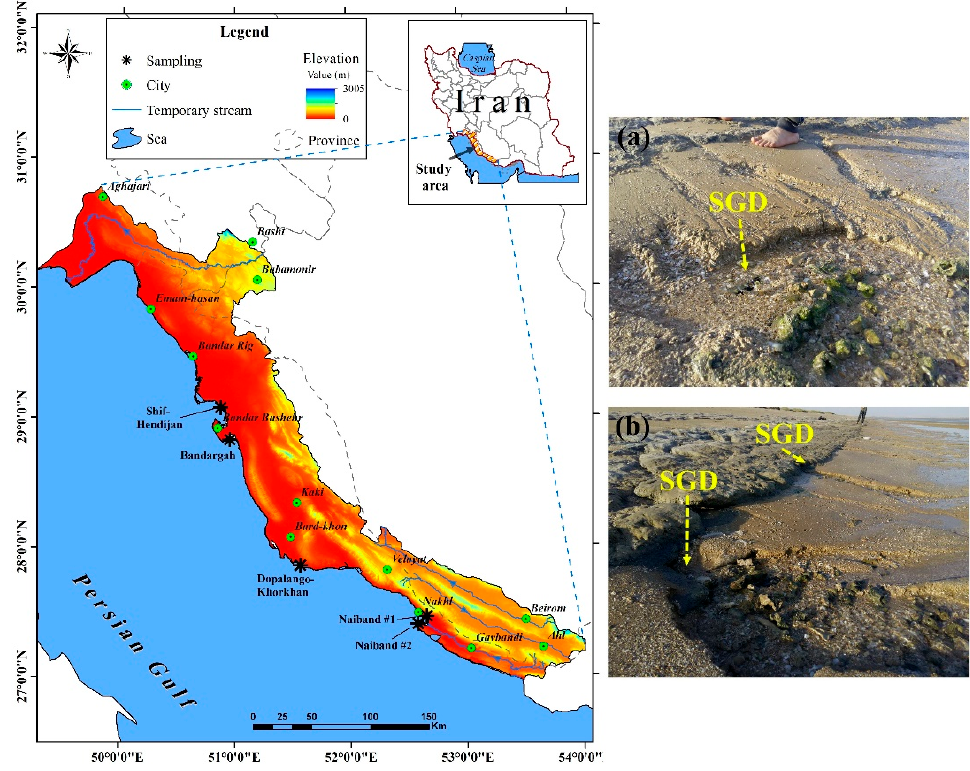
Figure 1. Location map of the study area in the south of Iran. Field photographs of some SGD occurrences in the study area: ( a ) Shif-Hendijan, and ( b ) Naiband #1.